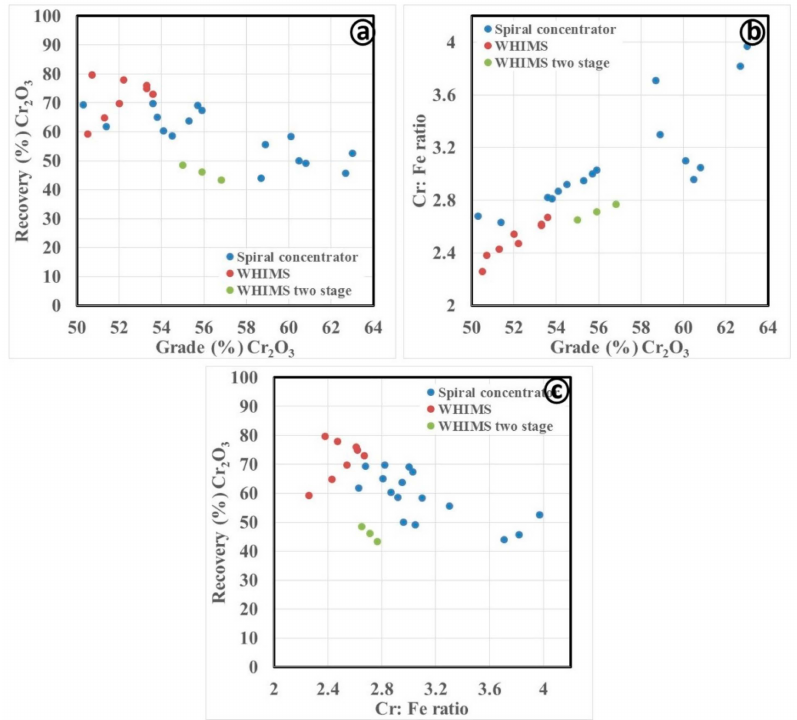
Figure 15. Comparison of the performance of the spiral concentrator and the WHIMS in treating coarse concentrate ( a ) for grade and recovery; ( b ) for grade and Cr:Fe rato; ( c ) for Cr:Fe rato and recovery.